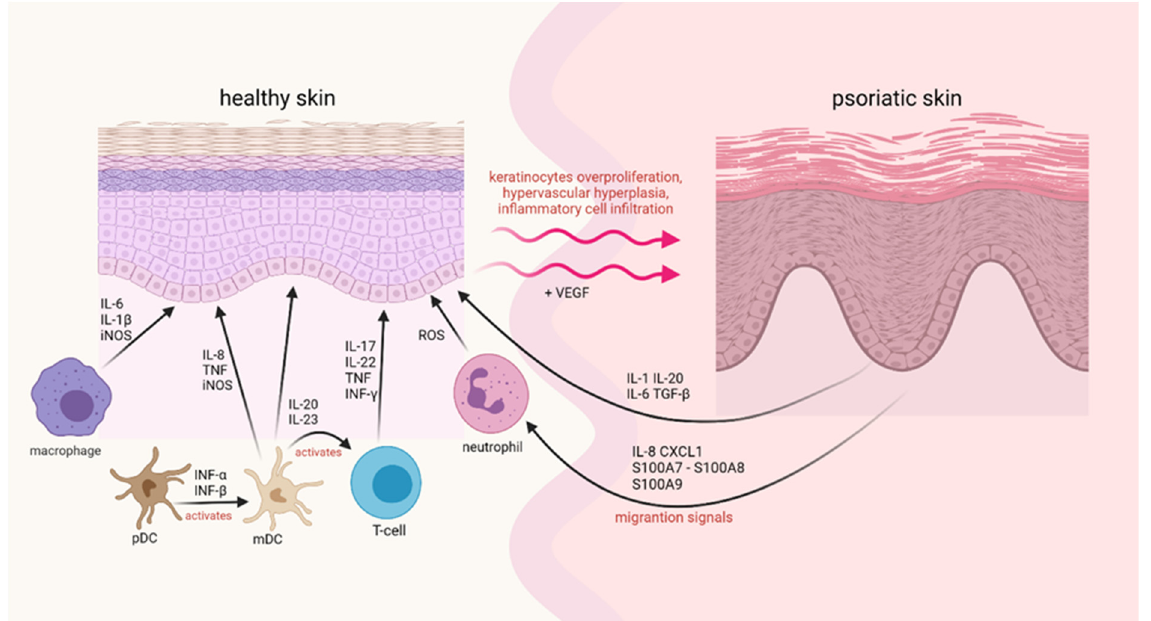
Figure 1. The scheme presents complicated mechanisms of the psoriasis course. Proinflammatory cytokines and other factors overproduced in psoriasis contribute to the increased proliferation of keratinocytes. Moreover, in psoriasis conditions, activation of inflammatory cells occurs and stimulates intense inflammation. These self-perpetuating loops of proinflammatory activators and effectors enhance the symptoms of this autoimmune